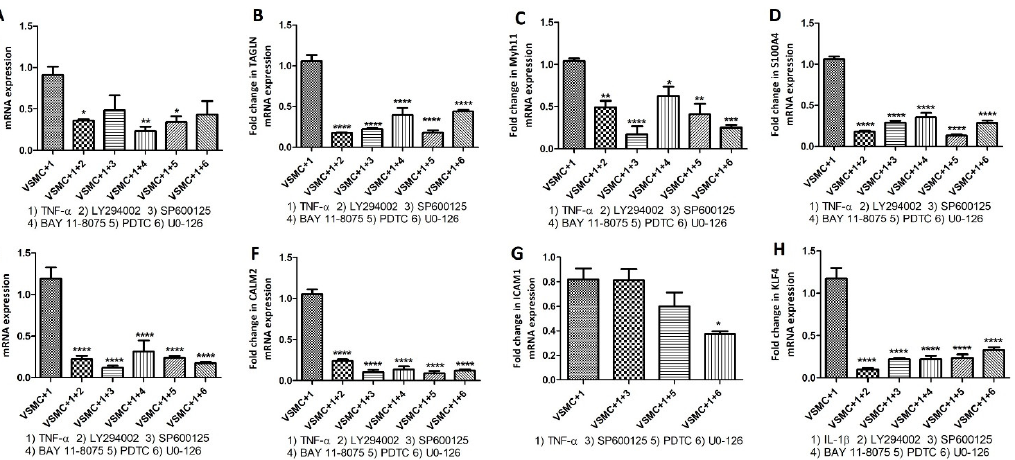
Figure 9. RT-qPCR to investigate the effect of TNF- α on VSMCs phenotype markers after inhibiting cytoplasmic kinases. RT-PCR data for alpha-smooth muscle actin ( α -SMA; panel A ), transgelin (TAGLN; panel B ), Myosin Heavy Chain 11 smooth muscle (Myh11; panel C ), S100 protein A4 (S100A4; panel D ), cytokeratin 18 (CK-18; panel E ), calmodulin 2 (CALM2; panel F ), Intercellular Adhesion Molecule 1 (ICAM1; panel G ), Krüppel-like factor 4 (KLF4; panel H ). α -SMA, TAGLN, and Myh11 (markers for contractile vascular smooth muscle cells (VSMCs)); CK-18, S100A4, CALM2, and ICAM1 (markers for proliferative VSMCs); and KLF4 (marker for de-differentiated VSMCs). Tumor necrosis factor (TNF)- α , LY294002 (PI3K inhibitor), SP600125 (JNK inhibitor), BAY 118075 (NF- κ B inhibitor), PDTC (NF- κ B inhibitor), and UO-126 (ERK inhibitor). All data are presented as mean ± standard deviation (SD). p < 0.05 is considered statistically significant. * p < 0.05, ** p < 0.01, *** p < 0.001, and **** p <